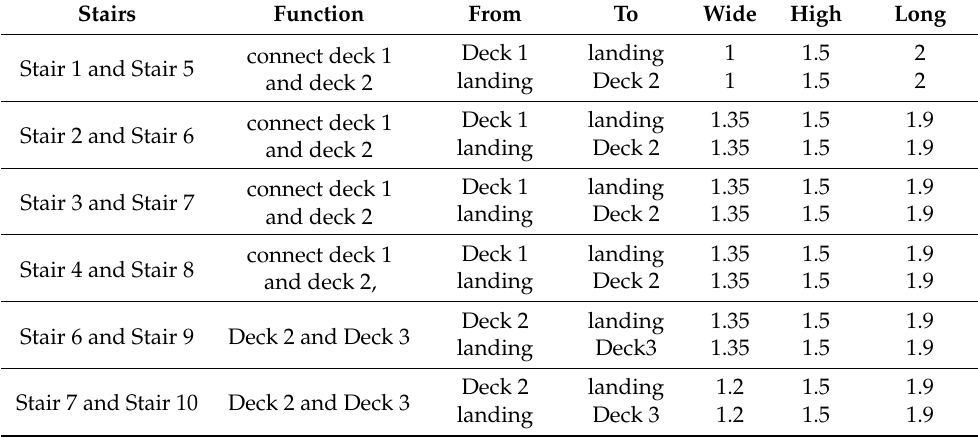
Table 1. Stair dimensions (unit: m).